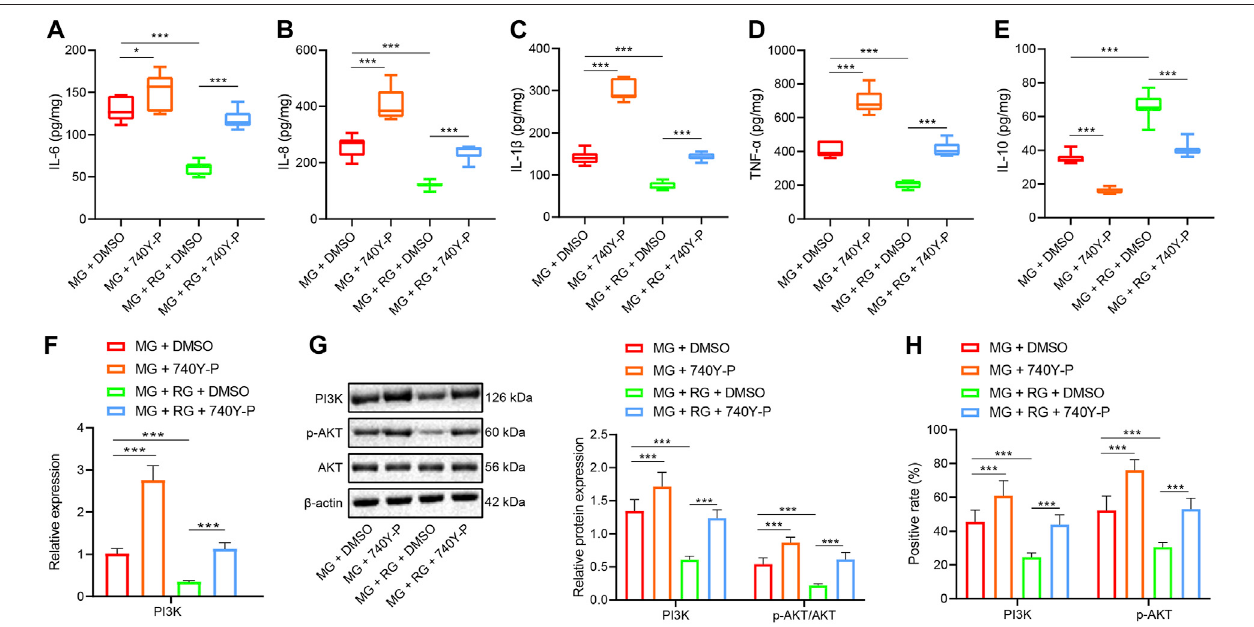
FIGURE 4 | Inhibition of PI3K/Akt pathway alleviates DSS-induced UC in mice. (A – E) The expression of IL-6, IL-8, IL-1 β , TNF- α , and IL-10 in the colon tissues of micein different treatment groups wasdetermined using ELISA. (F) The expression ofPI3K in colon tissues wasexamined using RT-qPCR. (G) The expression ofPI3K, p-Akt, and Akt protein in colon tissues was examined using Western blot. (H) The expression of VEGFA and Akt protein in colon tissues was detected using IHC. * p < 0.05, ** p < 0.01, and *** p < 0.001. n (cid:1) 20. Measurement data were expressed by mean ± SD. One-way ANOVA was conducted for multiple group comparison, followed by Tukey ’ s post hoc test. MG, model control group; RG, resveratrol group; 740Y-P, PI3K/Akt